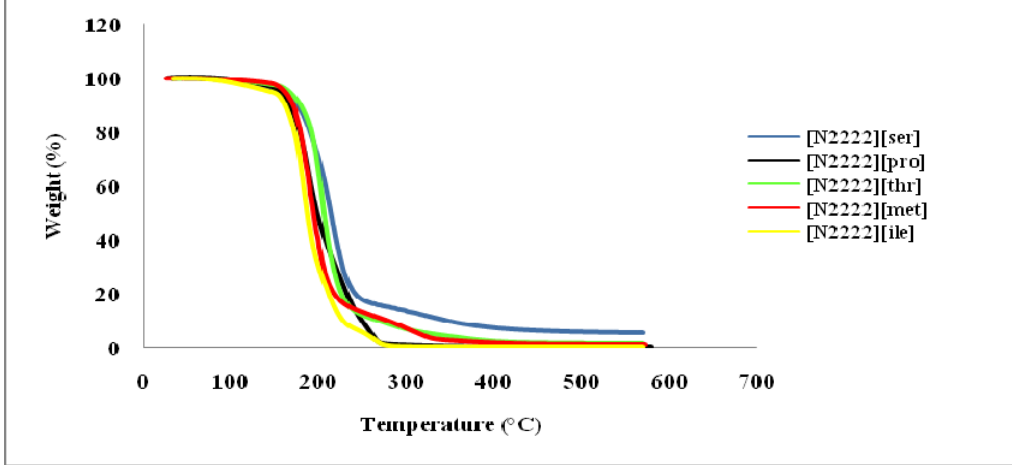
Figure 1. Thermogravimetric analysis of several new tetraethylammonium-based amino acids chiral ionic